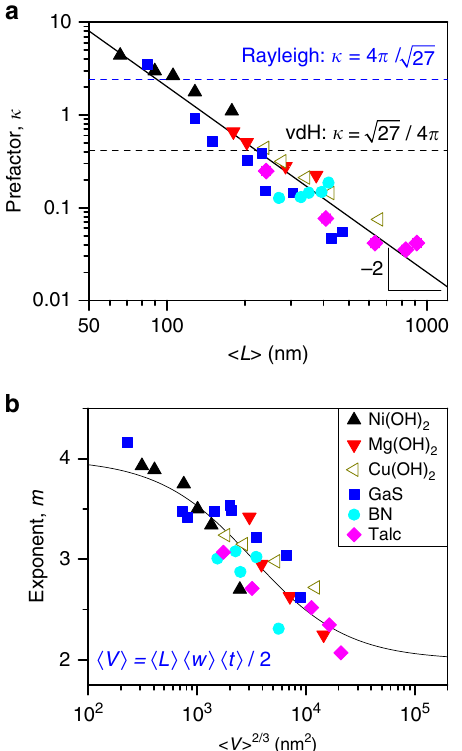
Fig. 7 Light scattering master-curves. a Scattering pre-factor, κ , plotted versus mean nanosheet length. The solid line shows an empirical power- law fi t while the dashed lines represents the high- λ expansion of the van de Hulst equation (Eq. 7) and the Rayleigh approximation (Eq. 4), both with D replaced by 〈 L 〉 . b Scattering exponent plotted versus characteristic nanosheet area ( 〈 V 〉 2/3 ) showing approximate master-curve behaviour. The line shows an empirical fi t. The legend in b applies to a and